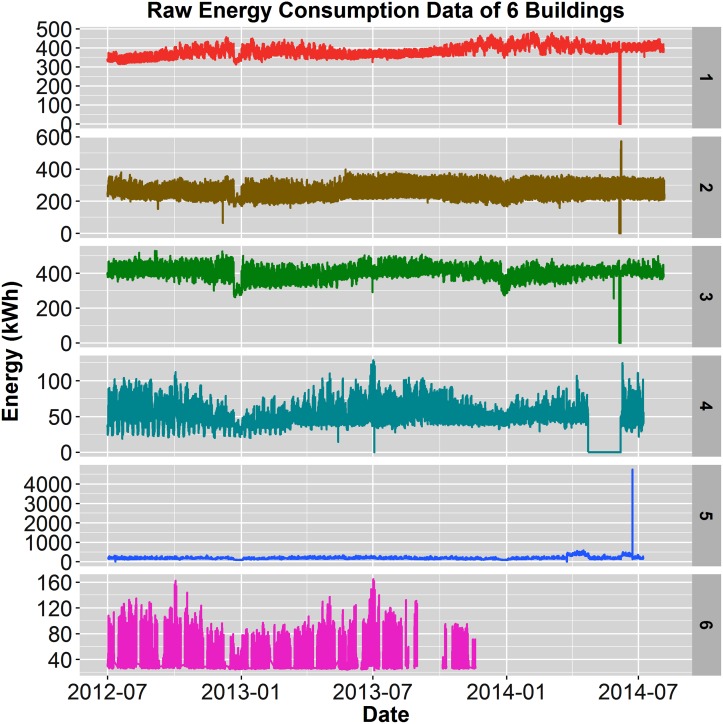
Raw electricity consumption.Raw electricity consumption data from full datasets for all 6 buildings(building number shown on the right most side of each plot). Building 5 shows the presence of outliers and mean-shifts; all buildings exhibit missing data.